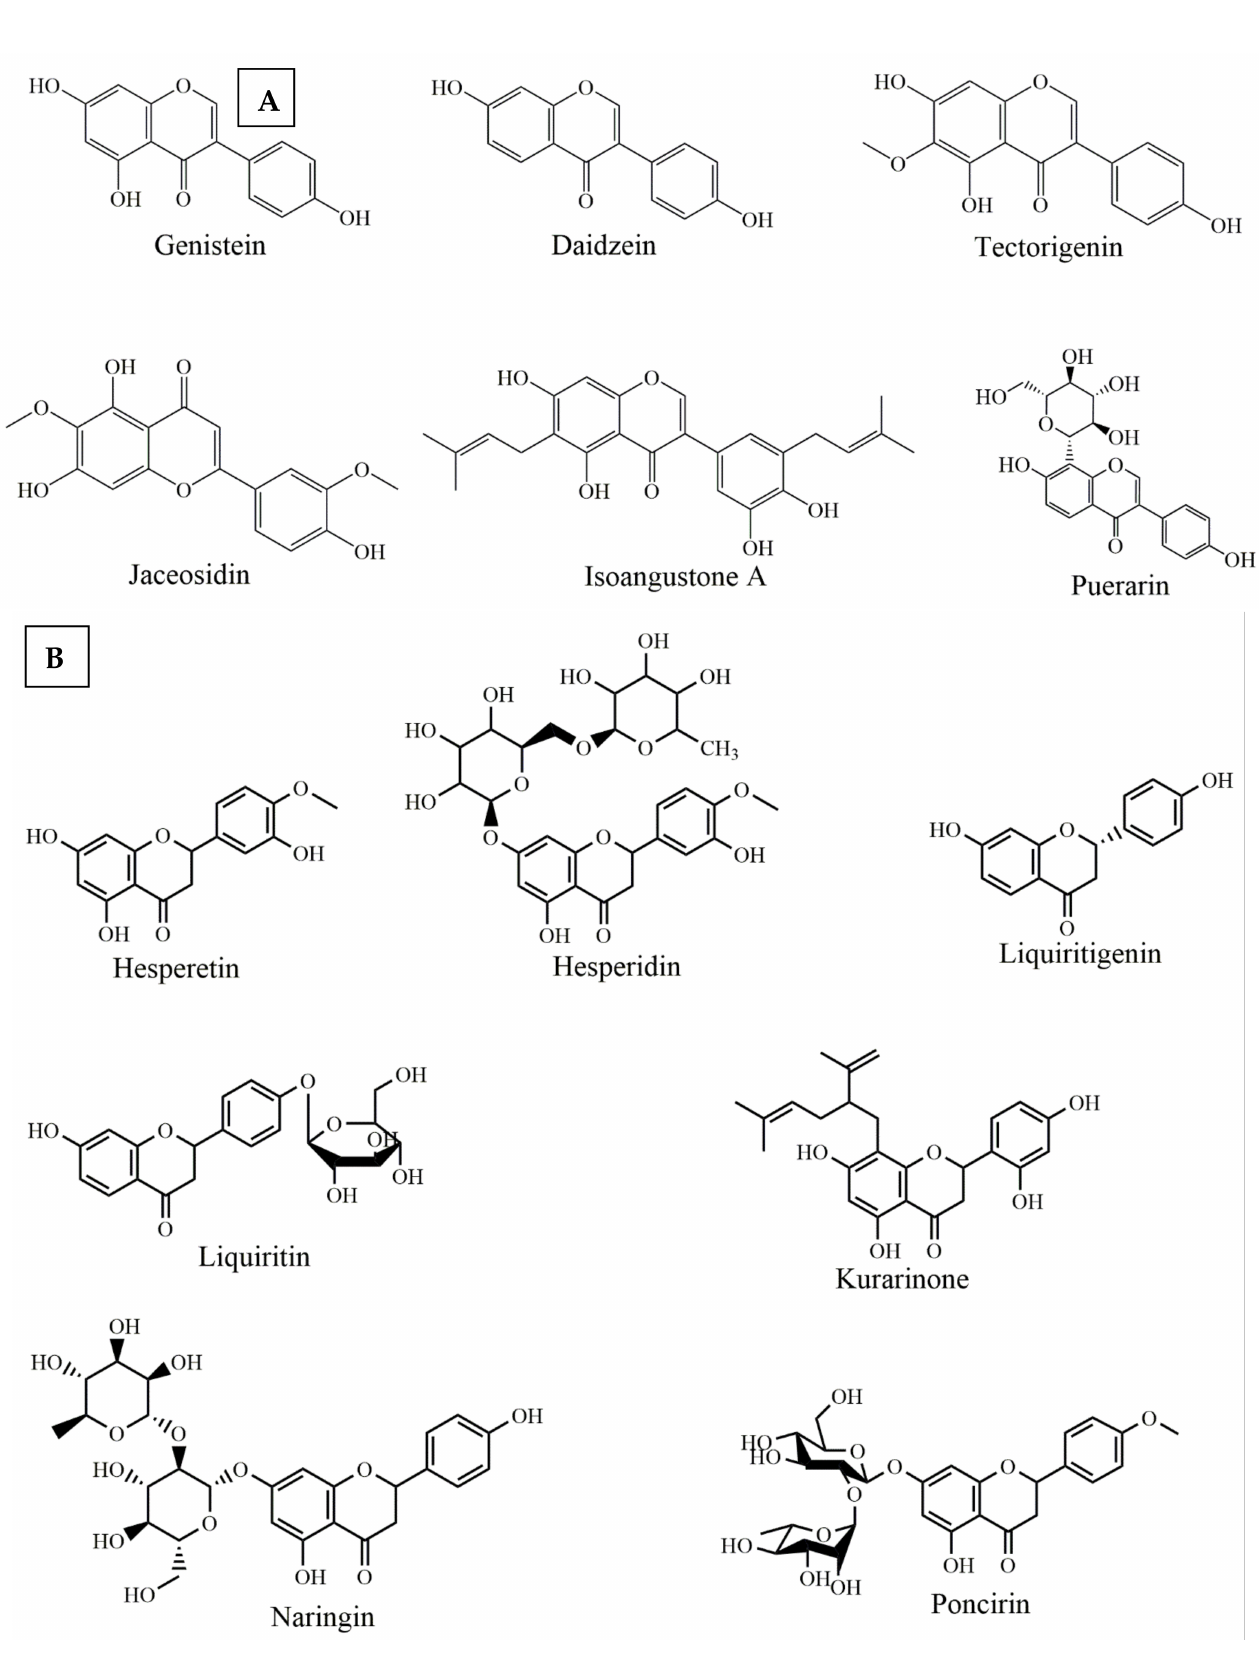
Figure 4. Selected chemical structures of isoflavones ( A ), and flavanones ( B ) targeting Bcl-2 in the p53